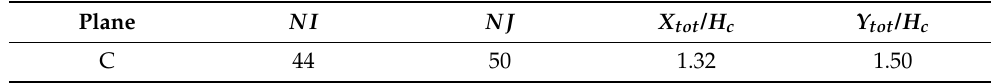
Table 3. Basic geometric and grid parameters: NI and NJ are the numbers of the grid lines with respect to the x and y direction, while X tot and Y tot are the x and y dimensions of the computational domain. Plane NI NJ X tot / H c